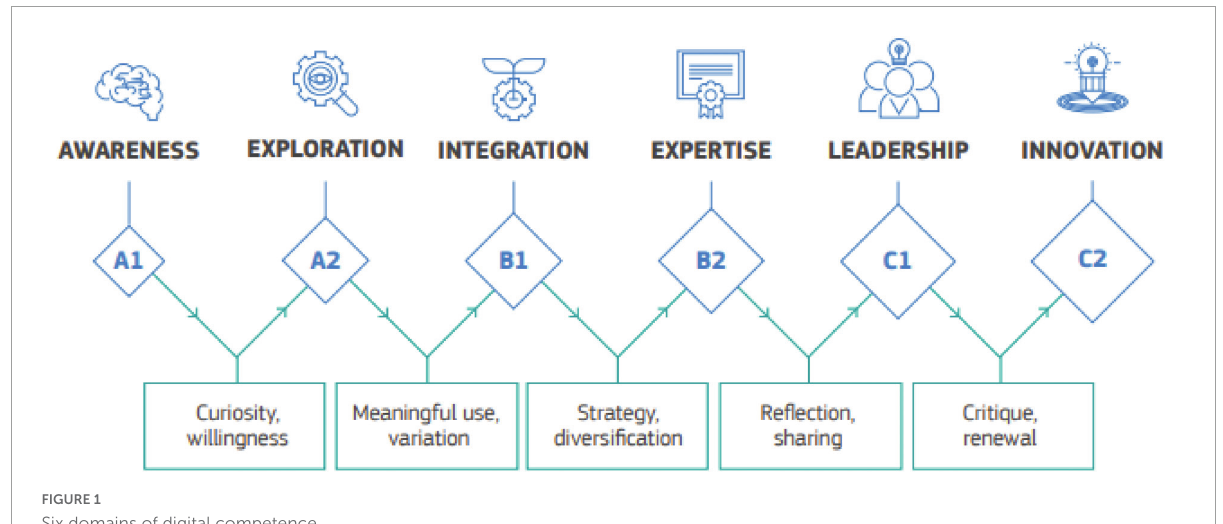
FIGURE1 Six domains of digital competence.